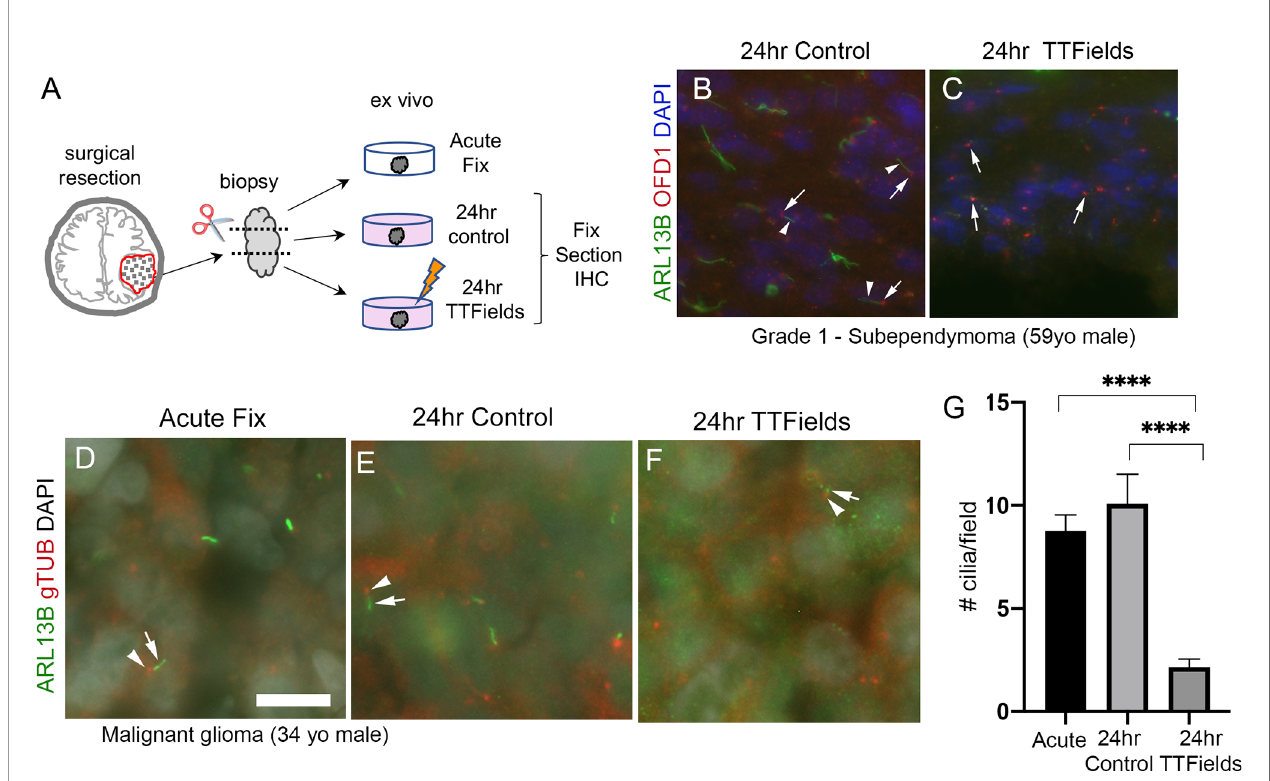
FIGURE 8 | TTFields disrupt cilia in patient samples ex vivo . (A) Ex vivo treatment of surgical resections. Biopsies were dissected and separated into immediate/ acute fi x, 24 h control or 24 TTFields treatment. Tissue was fi xed, frozen, cryosectioned, and immunostained. Nuclei are labeled with DAPI. (B) Immunostaining of control section of a grade 1 subependymoma showed ARL13B + cilia (arrowheads) extending from OFD1 + basal bodies (arrows). (C) TTFields-treated tissue section showed OFD1 + basal bodies (arrows) without obvious ARL13B + cilia extensions. (D – F) Tissue from a malignant glioma from a 34-year-old male that was separated into immediate/acute fi xation, 24-h control, or 24-h TTFields exposure. Tissues were fi xed, cryosectioned, and immunostained for ARL13B (green) and gTub (red), and nuclei labeled with DAPI (white). ARL13B + cilia (arrows) with gTUB + basal bodies (arrowheads) are readily detected in acute (D) and 24-h control (E) but appeared blunted or generally absent in TTFields group (F) . (G) Mean (+/ − SEM) number of cilia/ fi eld ( n = 12 – 13 fi elds/group) from samples in (D – F) . **** p < 0.0001 (ANOVA). Scale bars (in µm) in (A) =